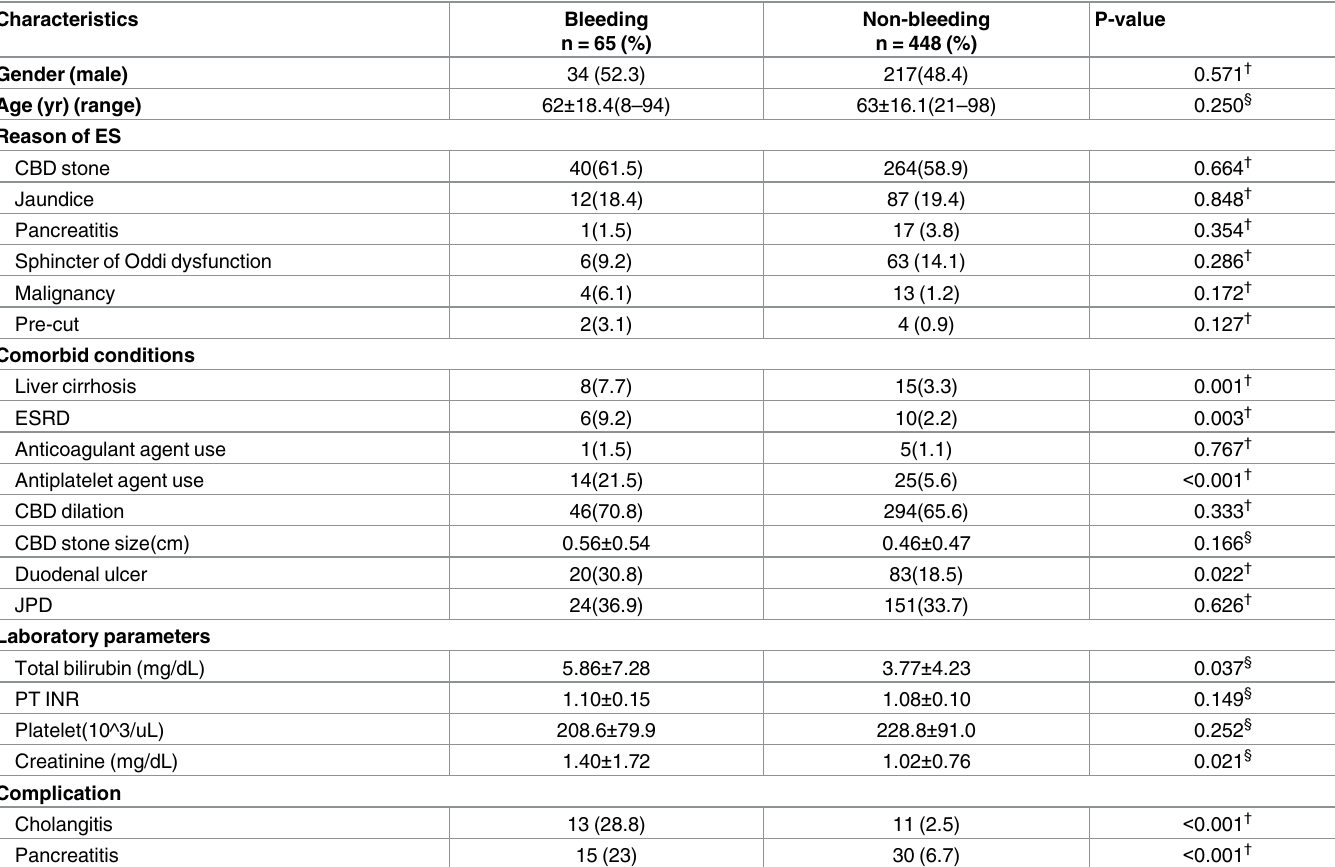
Abbreviations: ES, endoscopic sphincterotomy; ESRD, end-stage renal disease; CBD, common bile duct; JPD, juxtapapillary diverticulum,; PT INR, prothrombin ratio and international normalized ratio P value was determined using ANOVA § or Chi-squared test †